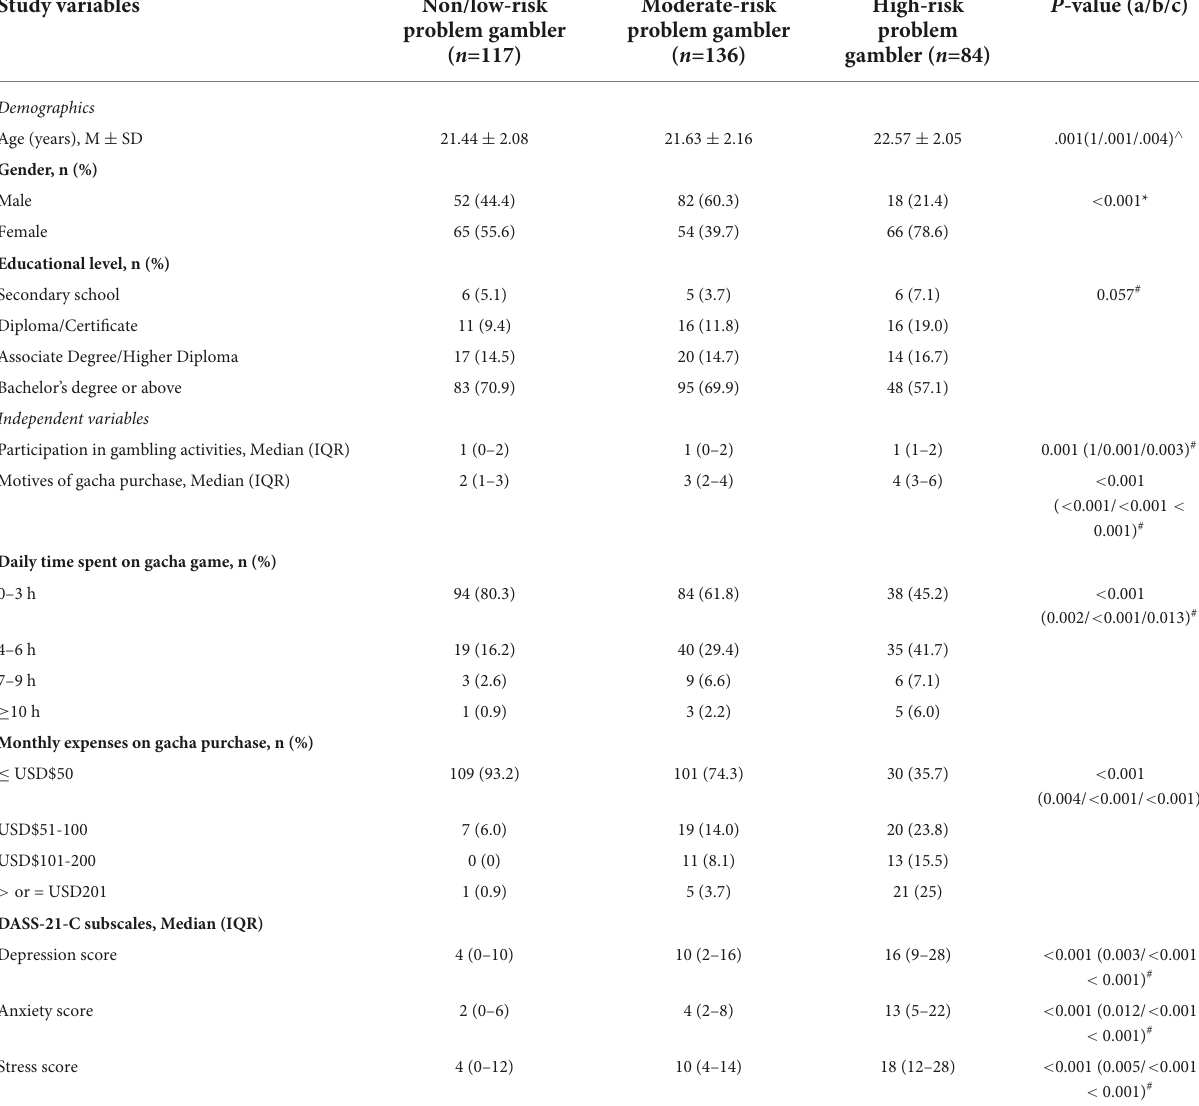
TABLE 1 Comparison among the three risk levels of problem gambling for demographic and independent variables ( N =337). Study